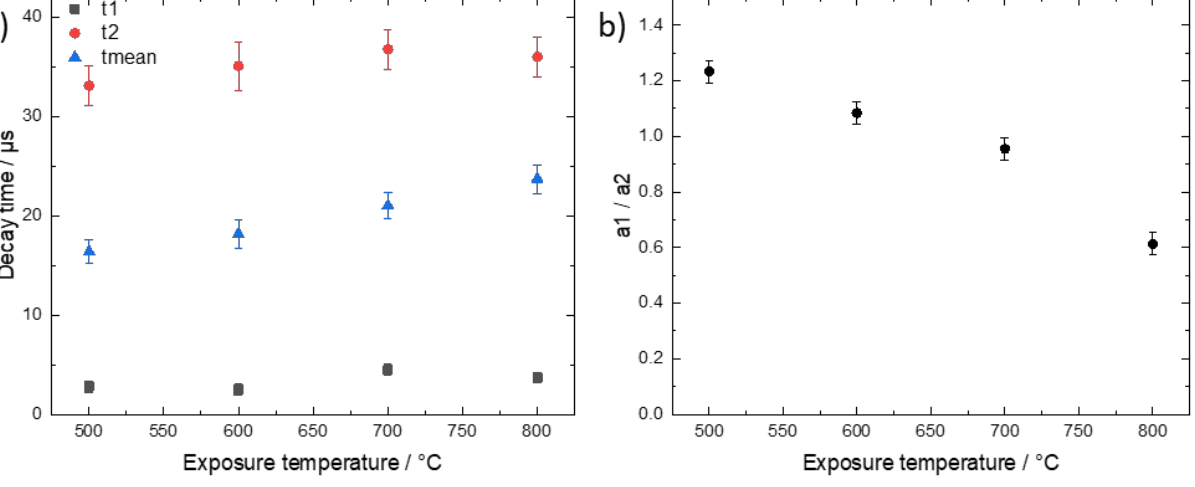
Figure 5. ( a ) Values of fast, slow, and mean decay times obtained by fitting a bi-exponential decay curve to the time-resolved phosphorescence data in dependence of exposure temperature. ( b ) Ratio of relative amplitudes of the fast (a1) and slow (a2) decay time components. The error bars reflect the range of fit parameters that yield the same goodness of fit.